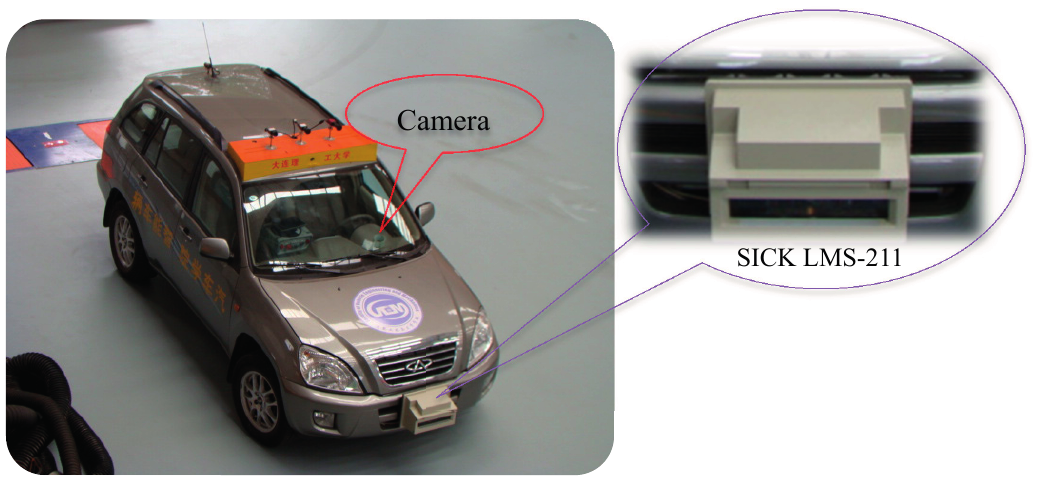
Figure 18. Platform for range estimation test.